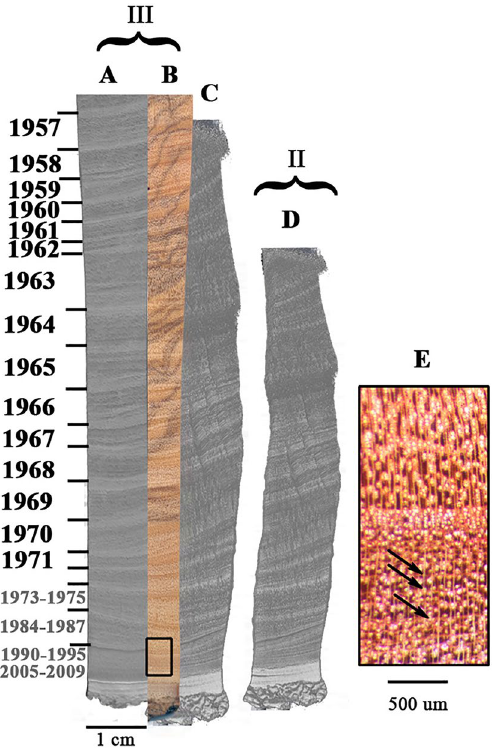
Figure 4. Micro-CT scan of olive wood. The micro-CT image of fresh wood ( A ) is shown in comparison to the actual image ( B ), both from segment III. ( D ) Charred sample from segment II after 30 min at 500 °C in continuous nitrogen flow. As charring caused warping and a decrease in size, ( C ) is the result of digitally stretching the original image ( D ), to more easily correlate the ring sequence to ( A ) and ( B ). Note that each marked ring is defined by a clear change in density, appearing as a strip of a lighter shade. Combining the radiocarbon data and δ 13 C patterns across the section, with the putative ring boundaries as seen in the micro-CT scan, each such defined ring was assigned a specific year. Year ranges in gray represent the calibration results from radiocarbon dating the cellulose extracted from sawdust encompassing the entire corresponding wood area for each result. ( E ) The magnified area outlined in ( B ), indicating examples of parenchyma bands, which can be interpreted as annual (see text). Ring widths between charred and fresh wood are compared in Figure S5 and Table